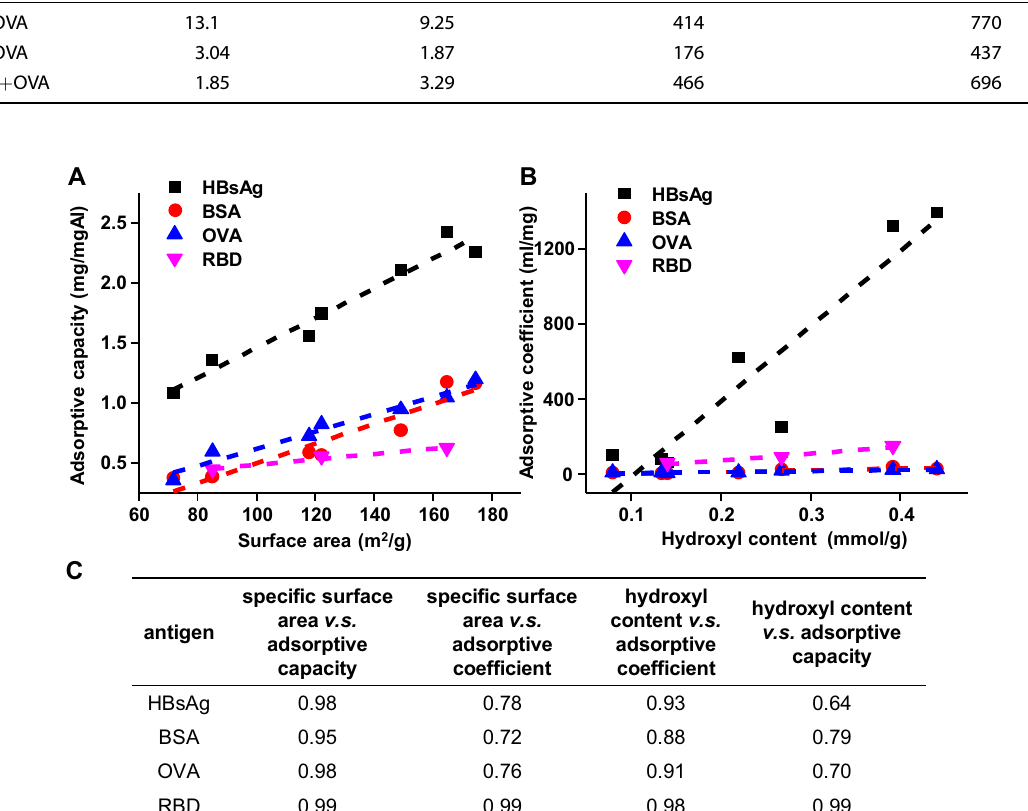
specific surface area v.s.